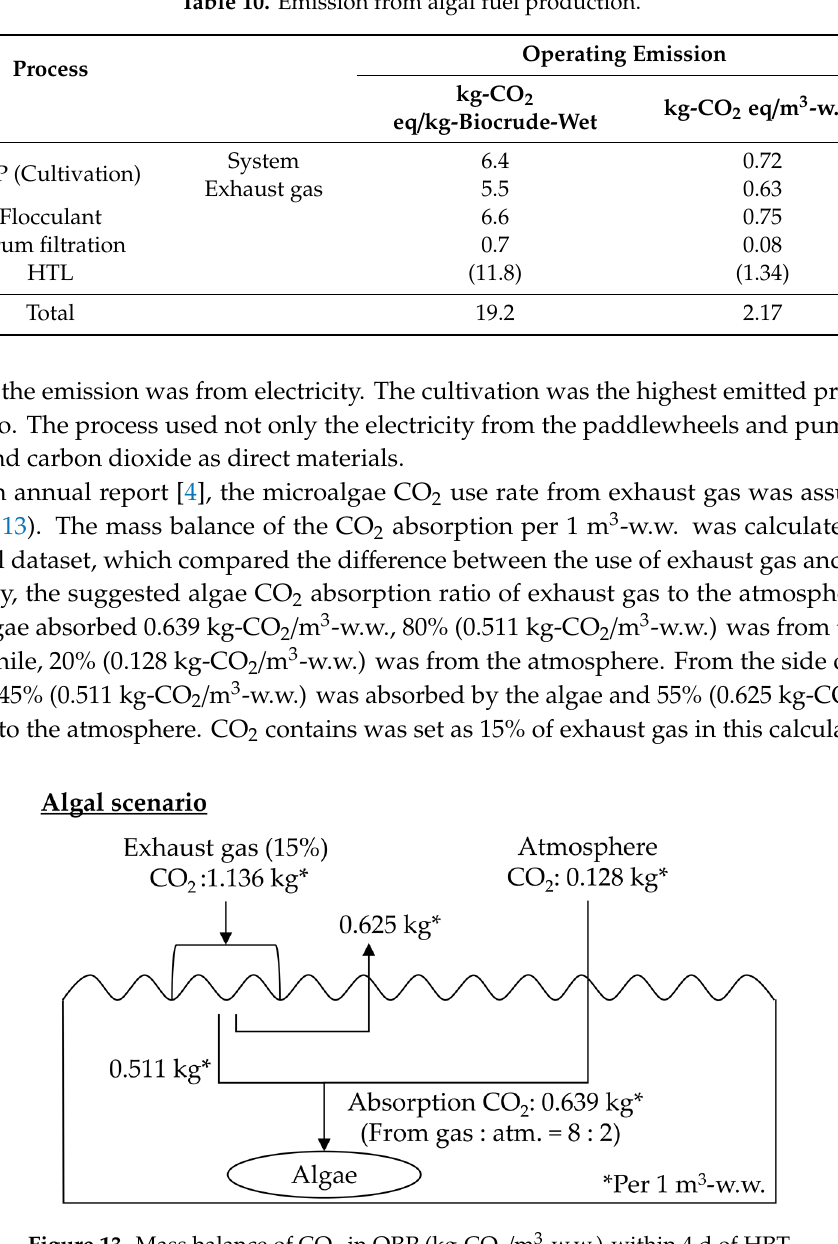
Figure 13. Mass balance of CO 2 in ORP (kg-CO 2 /m 3 -w.w.) within 4 d of HRT.